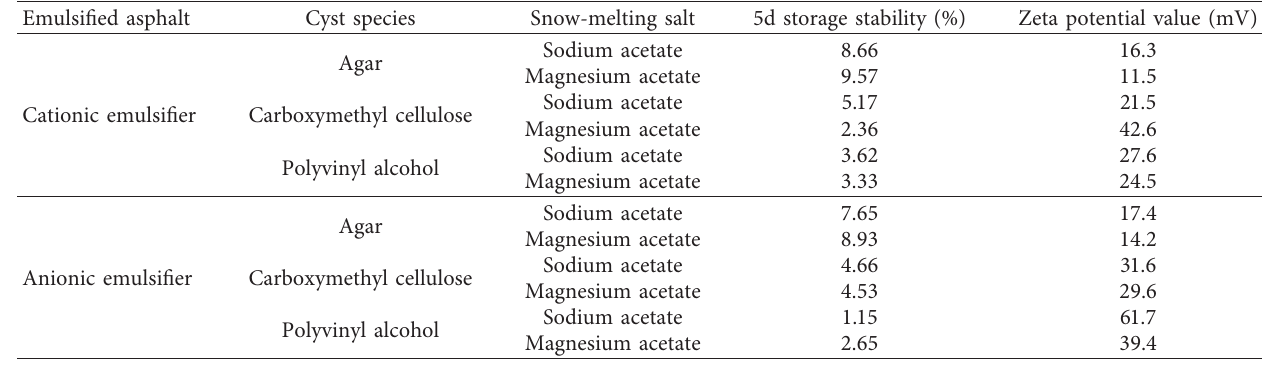
Table 5: Different effects on emulsion performance.